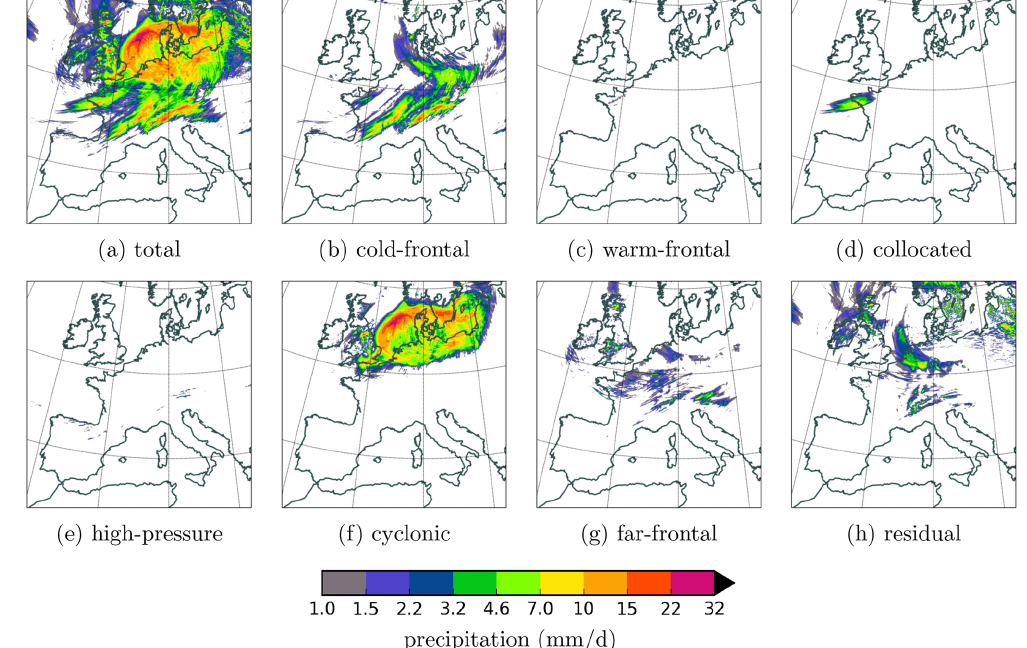
Figure 6. As in Fig. 4 but for Cyclone Uriah during the 4d period 24–27 June